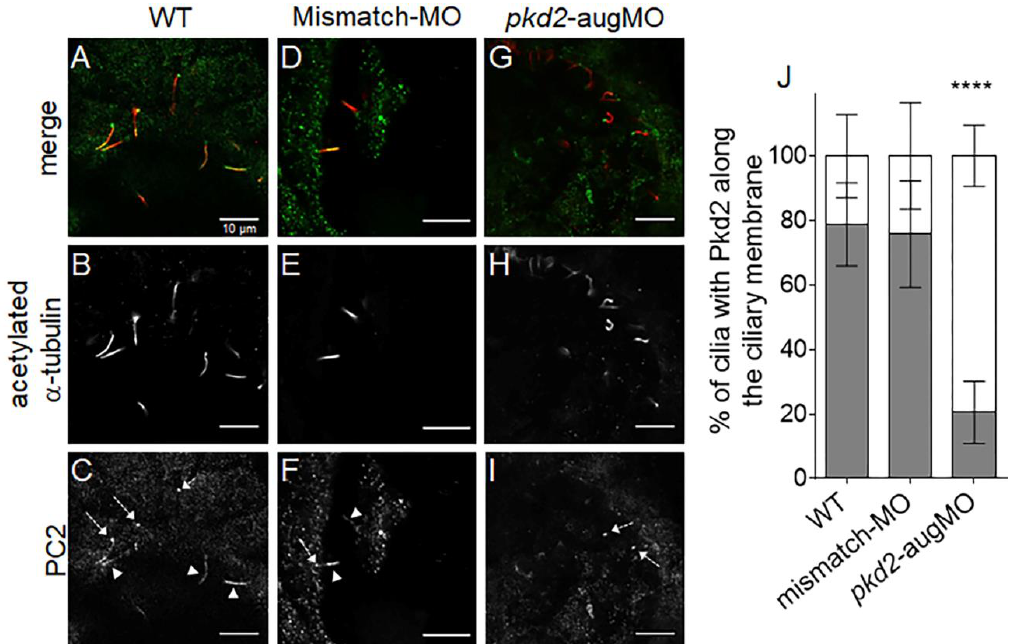
Figure 1. PC2 staining along the KV cilia from 10 ss embryos. ( A – I ) Confocal images showing immunolocalization of PC2 in KV cells at the 10–11 ss in WT ( A – C ), mismatch-MO ( D – F ), and PC2-knockown ( pkd2 -augMO) ( G – I ) embryos. White arrowheads indicate PC2 detected along cilia and dashed arrows indicate PC2 at the cilia basal body. ( J ) Quantification of the percentage of cilia having PC2 signal along their membrane (gray bars) versus those with no PC2 staining along their membrane (white bars) in WT ( n = 16), mismatch-MO ( n = 8), and PC2-knockown ( n = 8) embryos, immunodetected for acetylated α-tubulin. All samples followed a normal distribution and presented equal variances. Differences were, thus, statistically tested by t -test, **** p < 0.0001. Scale bars: 10 μm.